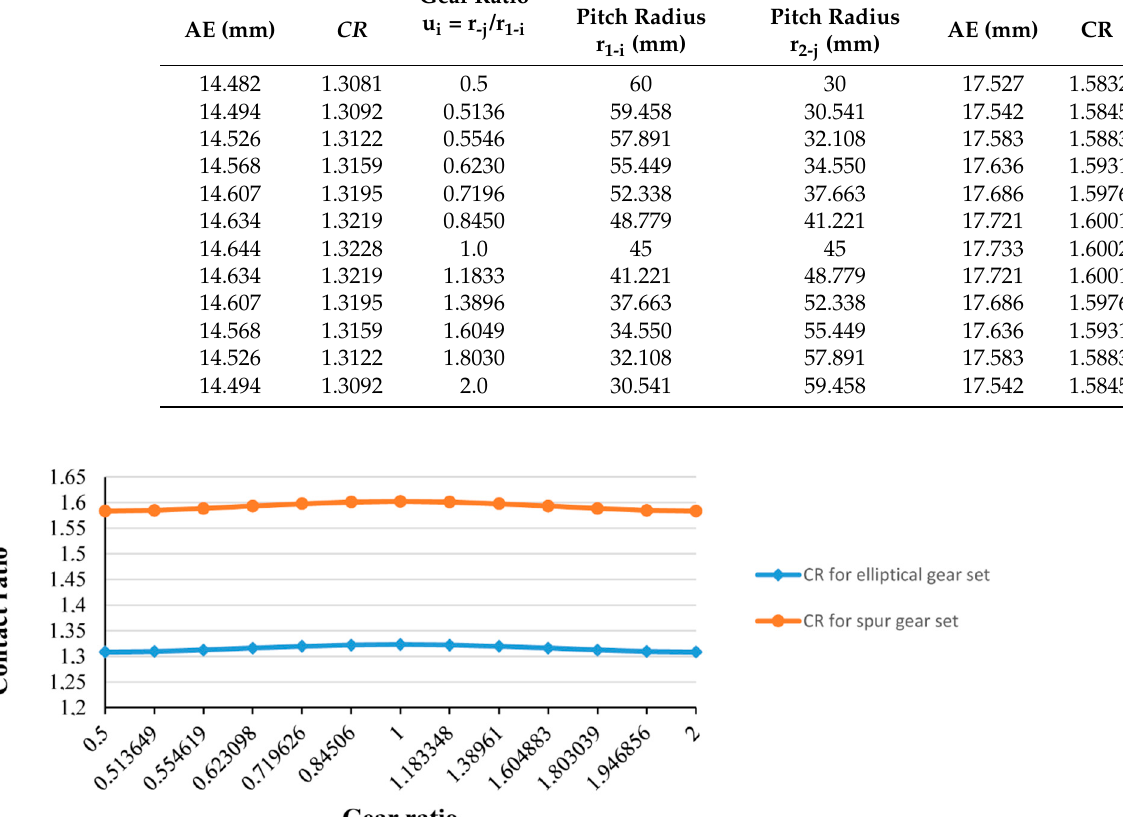
Figure 25. Comparison of the change of the contact ratio parameter. Designed elliptical gearing has the greatest meshing line AE value for the teeth mesh- ing pair which has a gear ratio u = 1.0. This elliptical gearing is characterized in that the gearing is composed of teeth whose profiles are not the same shape. Therefore, the length of the meshing line AE and contact ratio are not constant for each pair of teeth in meshing, as in a standard circular spur gear. In Figure 26, the velocity diagram for intermeshing teeth 4 (driving gear) and 8 (driven gear) in the central point of mesh is shown.